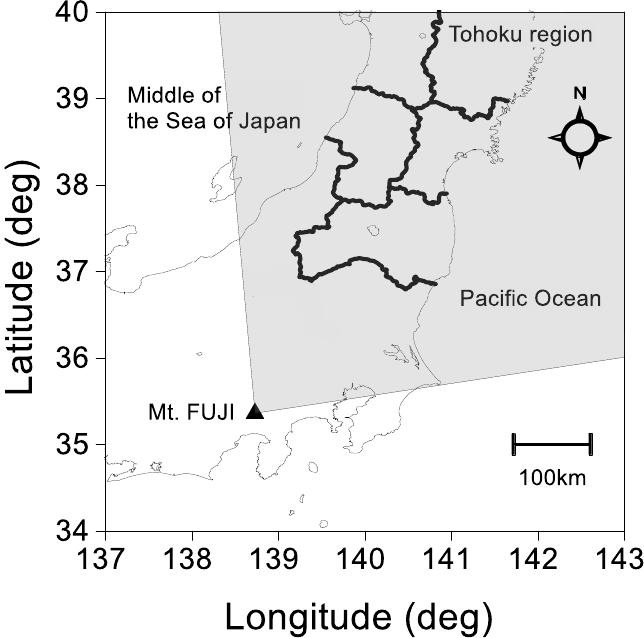
Figure 1. Configuration of the summer TLE observation for the 2013 Mt. Fuji campaign. The shadow denotes the detectable area (FOV: field of view) for TLEs from the summit of Mt. Fuji (black triangle: (cid:78) ) using CCD cameras. The bold line indicates the border of the prefecture in the Tohoku